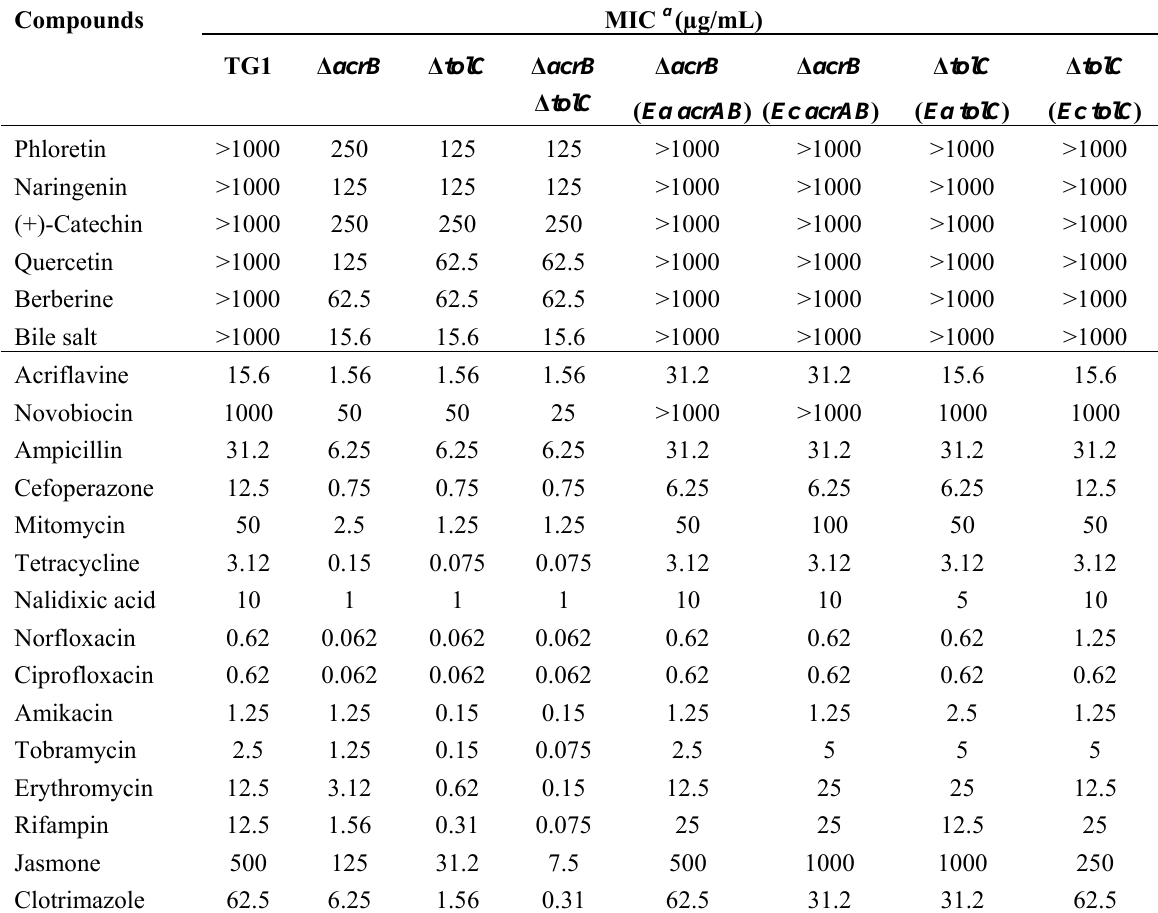
Table 1. Susceptibility of Escherichia coli strains to different compounds in complex medium